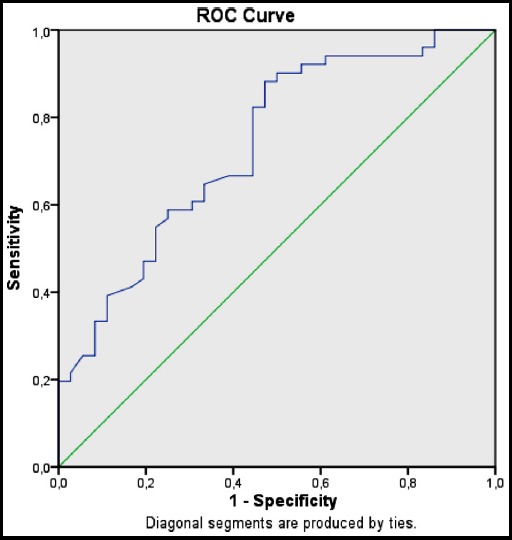
ROC curve comparing endocan levels with CURB-65 score.